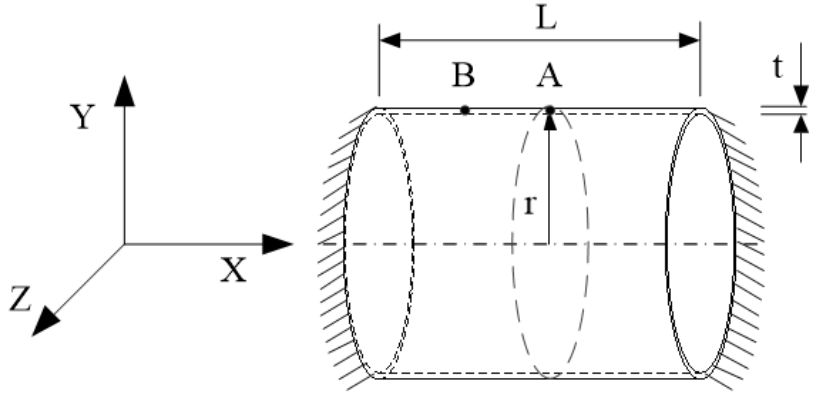
Figure 9. Hollow Figure 9. Hollow cylinder.